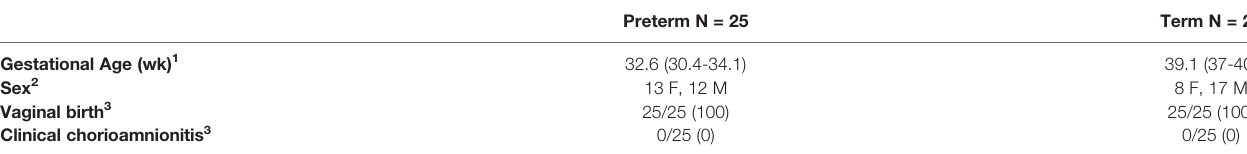
TABLE 1 | Characteristics of preterm and term infants.